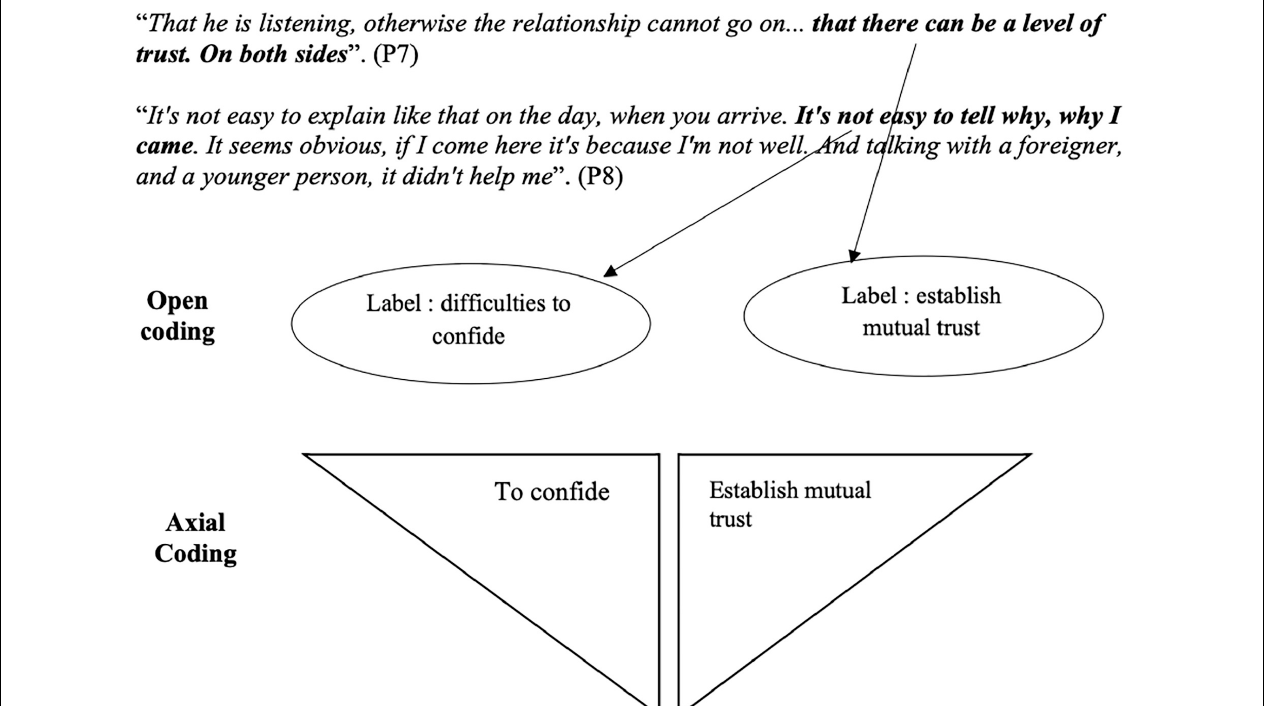
FIGURE 2 | Example of the transition from open coding to axial